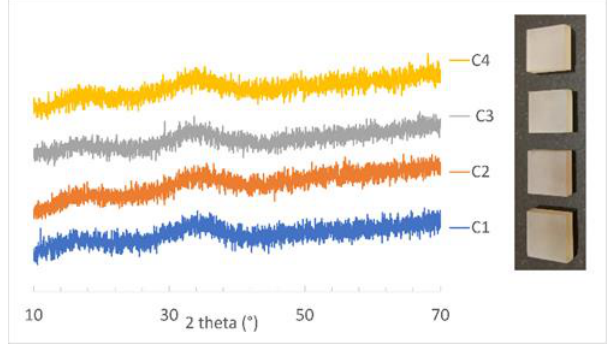
Figure 4. XRD patterns of the parent glasses.